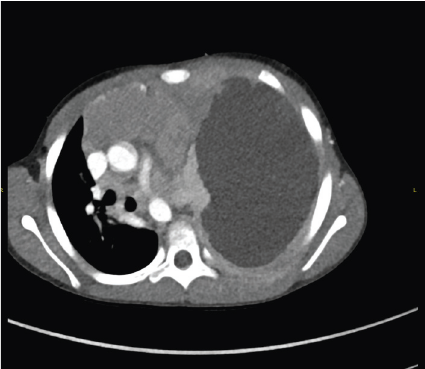
Figure 2: Chest computed tomography showing large right pleural effusion and anterior mediastinal mass with the mass effect.